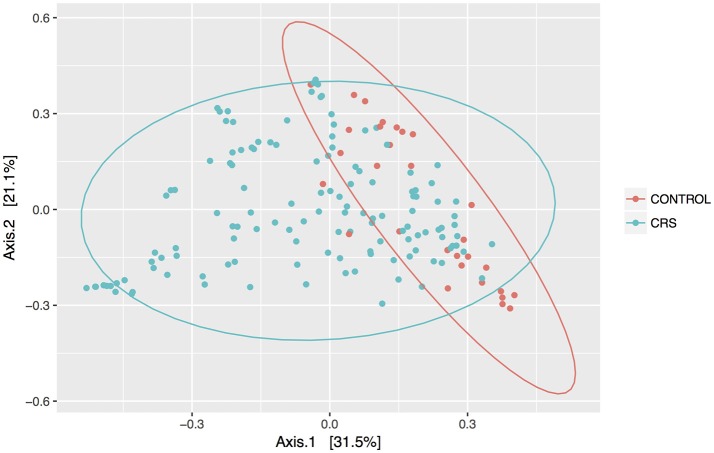
PCoA of weighted Unifrac distances. Samples from sinus cavities only are included, and ellipses represent 95% confidence intervals.